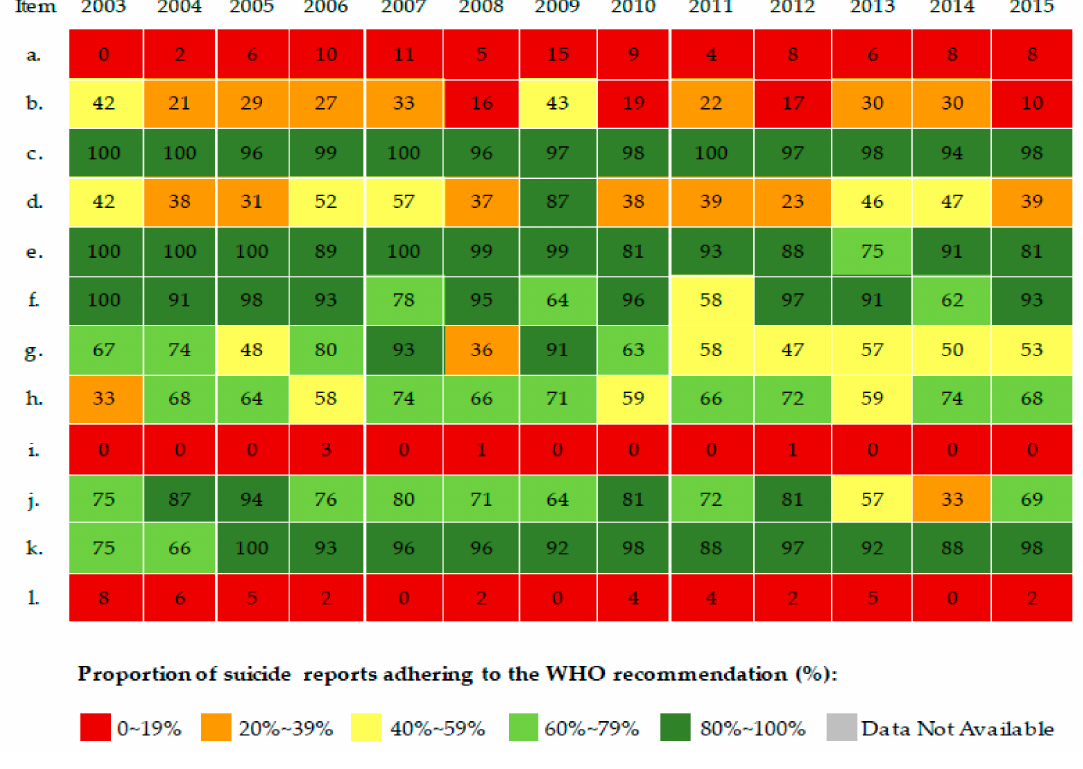
Figure 3. Proportion of suicide news stories applying the WHO recommendations in the top 10 Internet-based media sources in China,